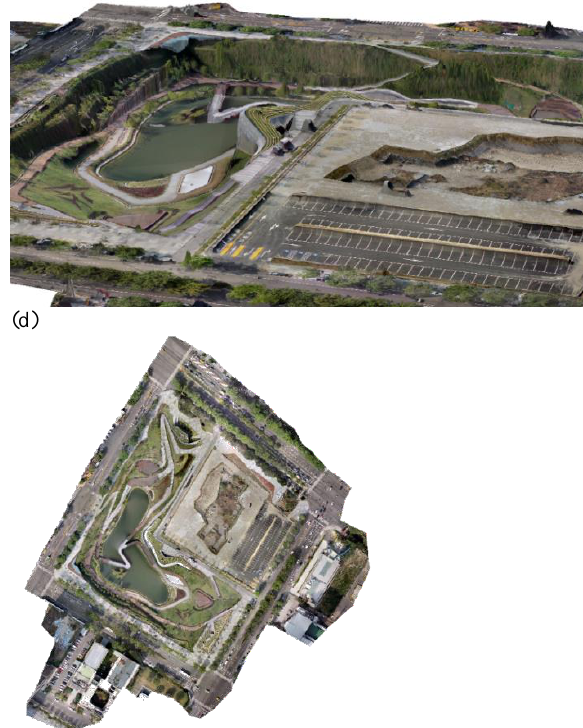
Figure 3. (a) surface constructed from the 3D point clouds (b)